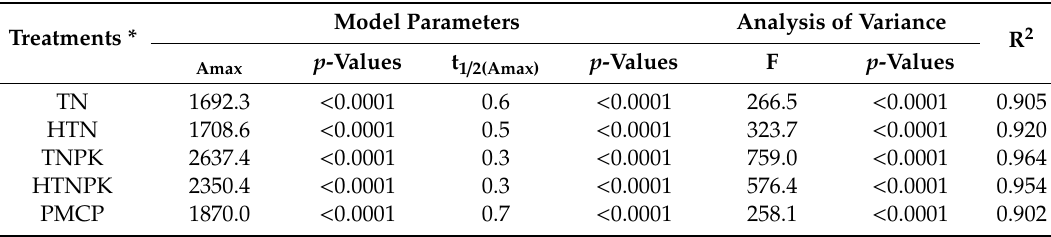
Table 6. Estimation model for K release from di ff erent types of the blended biochar pellet. Treatments *